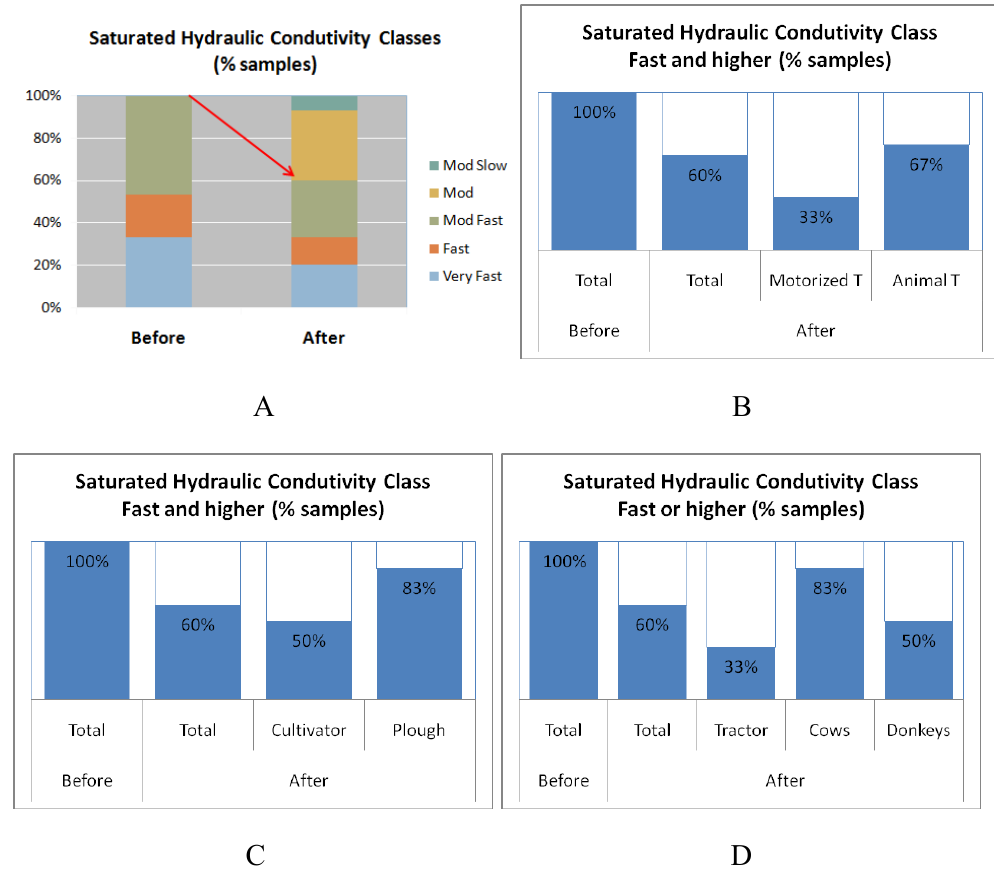
Figure 4: Effects of treatments on Saturated Hydraulic Conductivity class distribution at surface soil layer (0-0.05 m depth): A – Operations global effect; B – Motorized and Animal Traction effects; C – Implement effect; D – Traction mean